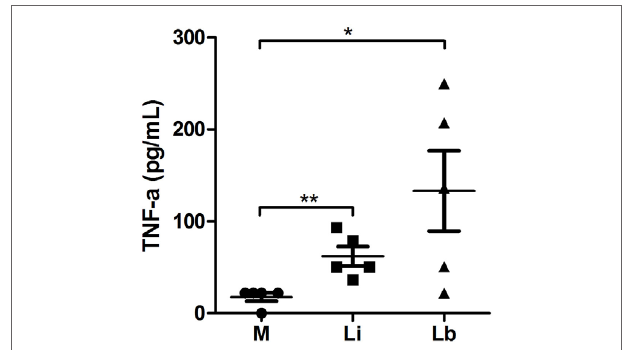
FigUre 6 | L. braziliensis induced TnF- α secretion on immature Dcs – cytokine levels measured on culture supernatants after 24 h of infection . Control DCs were cultured in cytokine-conditioned media only or treated with viable L. infantum or L. braziliensis parasites. Median ± SD. Each point represents one donor. * p < 0.05, ** p <